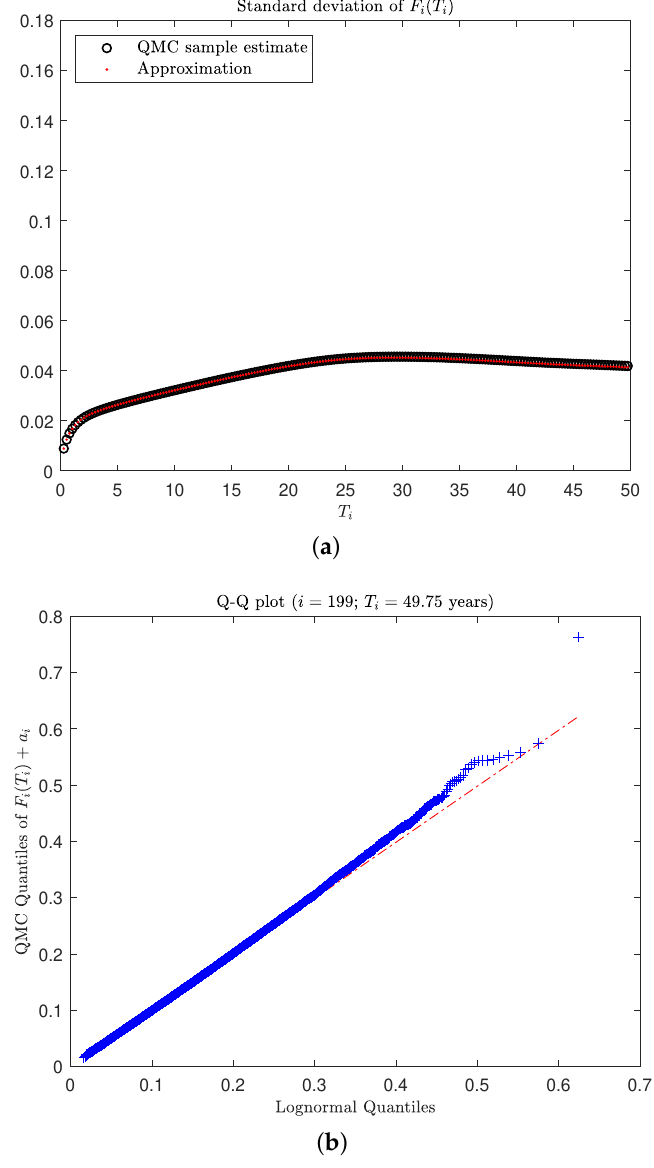
Figure 6. Implications of using the damped instantaneous volatility function (36) on realised forward LIBOR standard deviation and the approximate lognormality at the 50 year maturity under the five- factor DLFM scenario. ( a ) Comparing the realised forward LIBOR standard deviation approximation to a benchmark QMC sample estimate (on the same scale Figure 3a). ( b ) A lognormal Q–Q plot for the realised QMC sample of the forward LIBOR maturing at 50